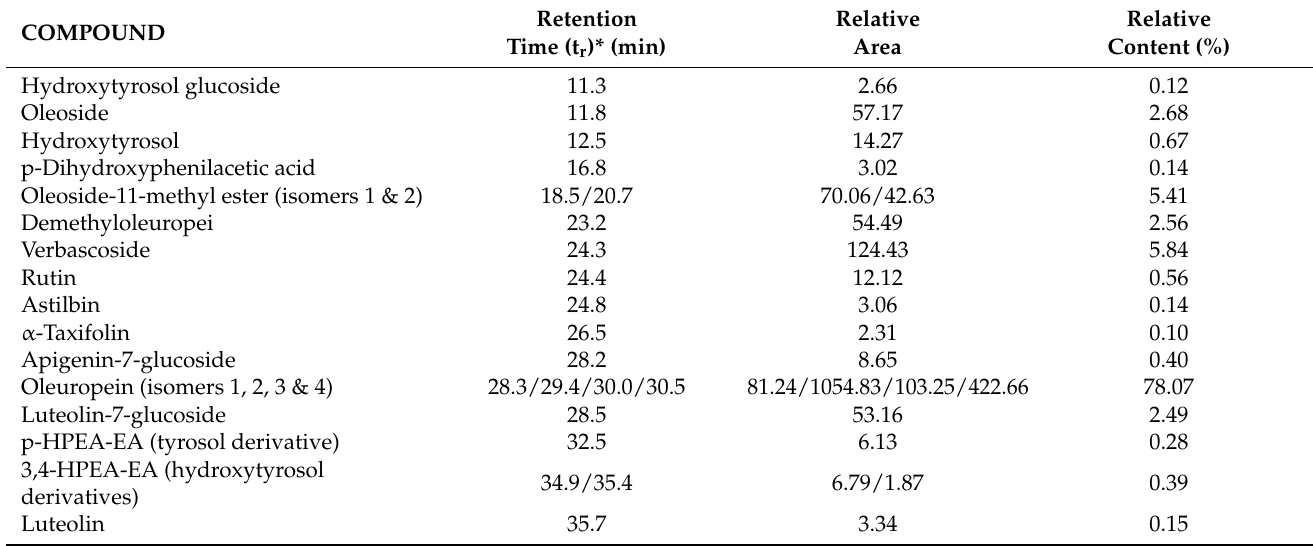
Table 1. Phenolic profile of the Olea europaea leaf extract (OELE) by LC-MS/MS